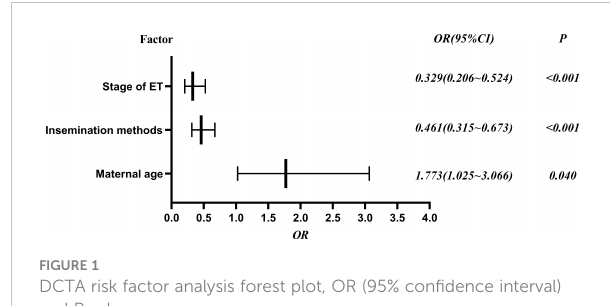
FIGURE 1 DCTA risk factor analysis forest plot, OR (95% con fi dence interval) and P